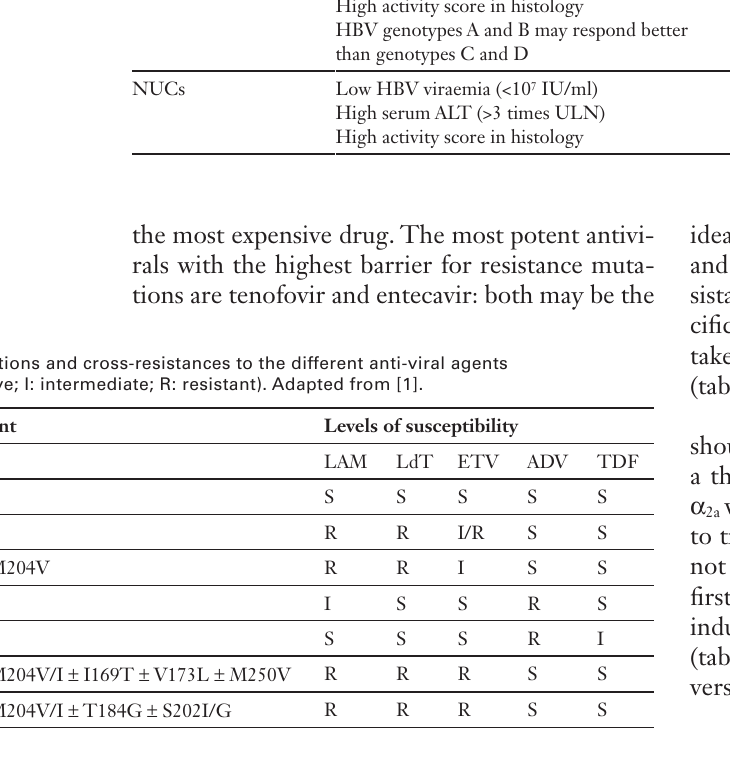
Pre-treatment and on-treatment predictors.